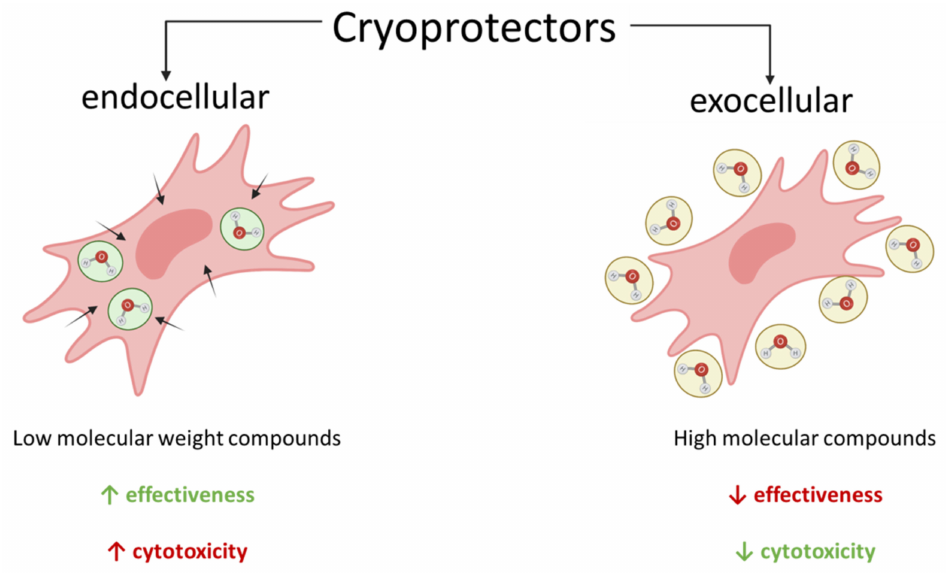
Figure 2. Types of cryoprotectors.